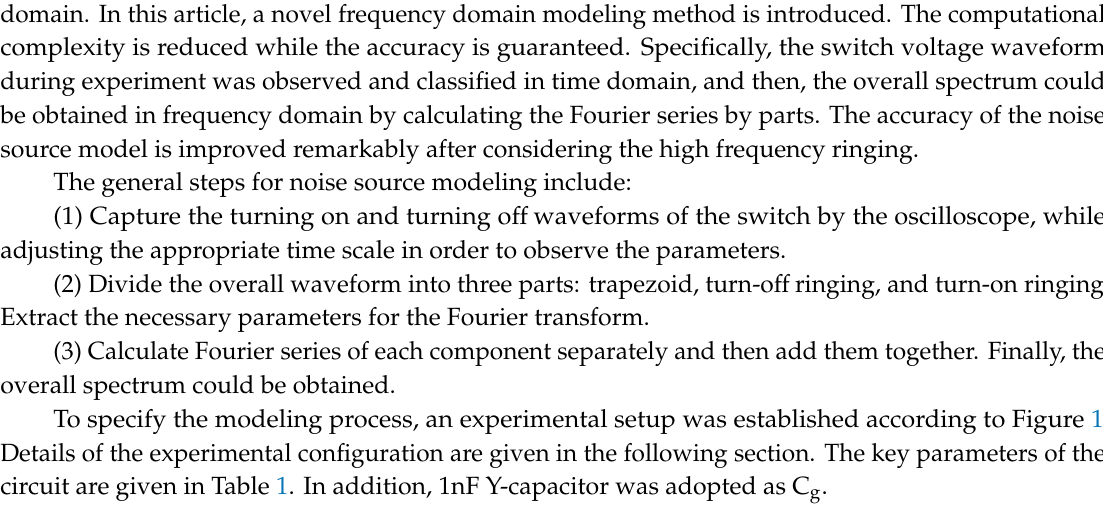
Table 1. Key parameters of CBC.